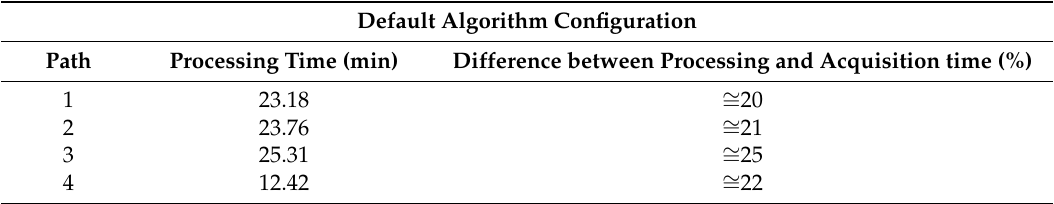
Table 3. Processing time of raw data with default setting of full SLAM parameters.